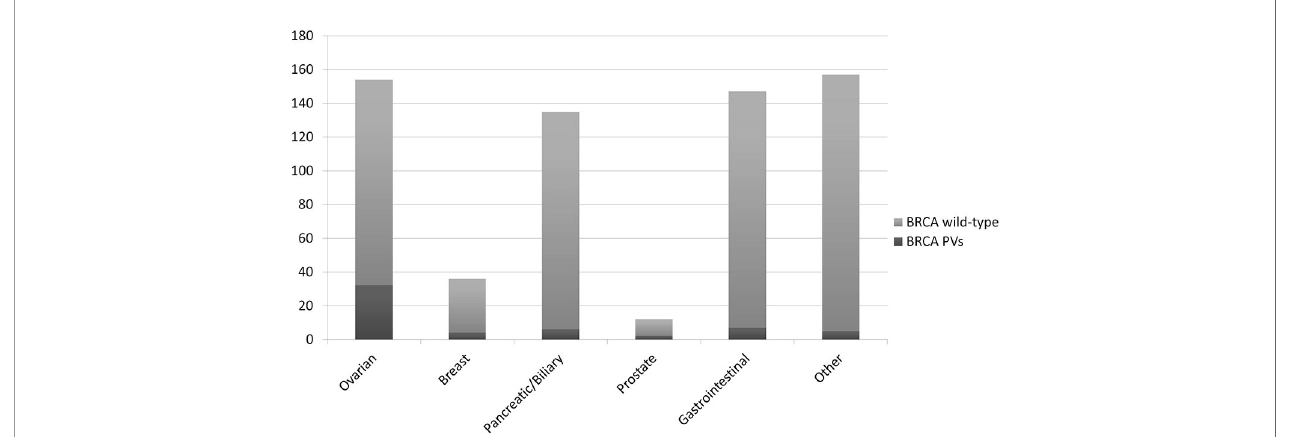
FIGURE 2 | Detection rate of BRCA pathogenic/likely pathogenic variants (PVs) at tumour testing in different primary tumours.